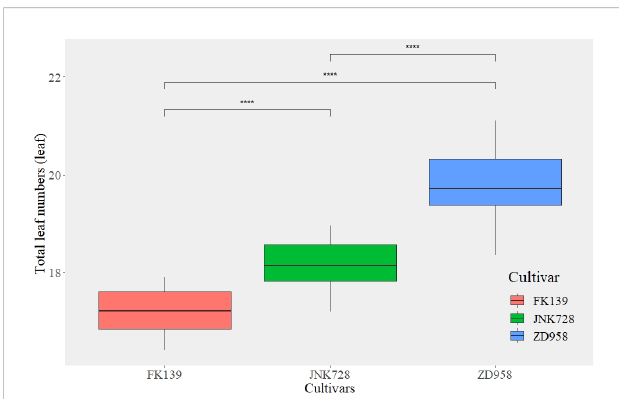
FIGURE 3 The total leaf number among different maize cultivars. ****are used to indicate signi fi cance levels at P < 0.0001.